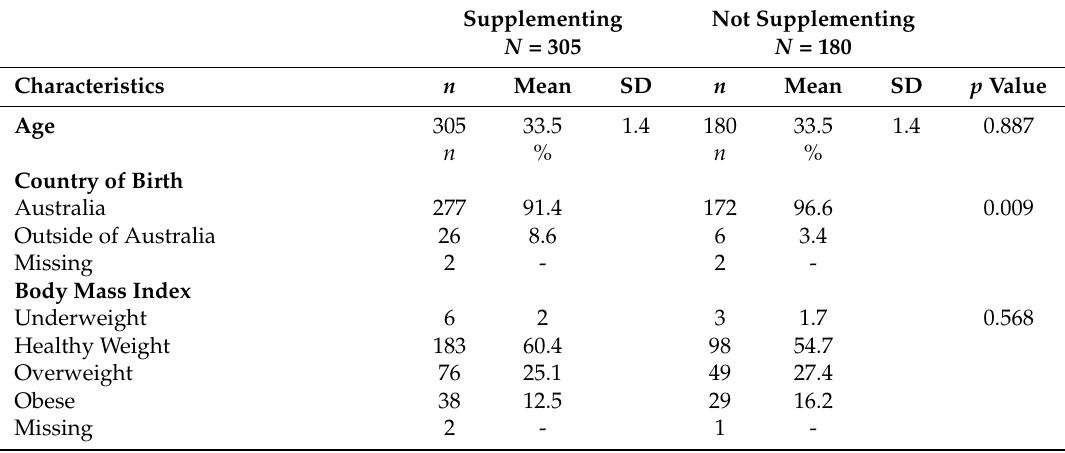
Table 2. Demographic characteristics of women aged 31–36 years in 2009 from the